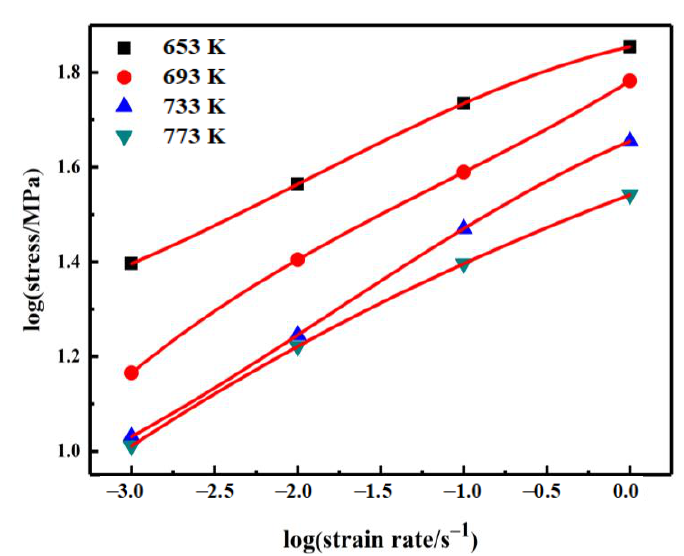
Figure 4. Interpolation curve of the flow stress and strain